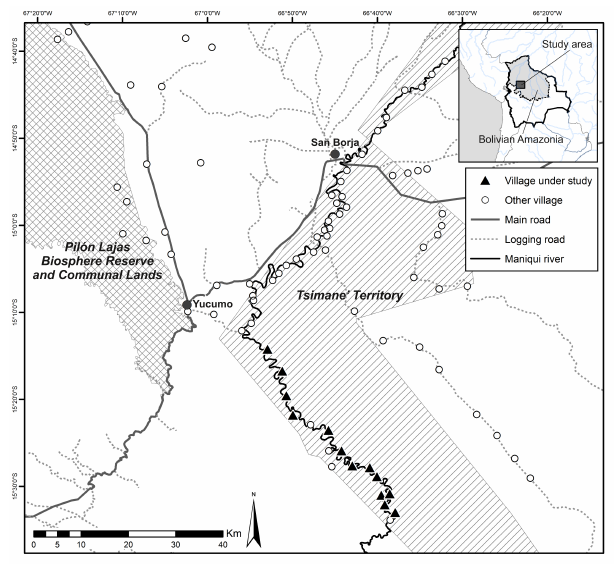
Fig. 1 . Map of the study